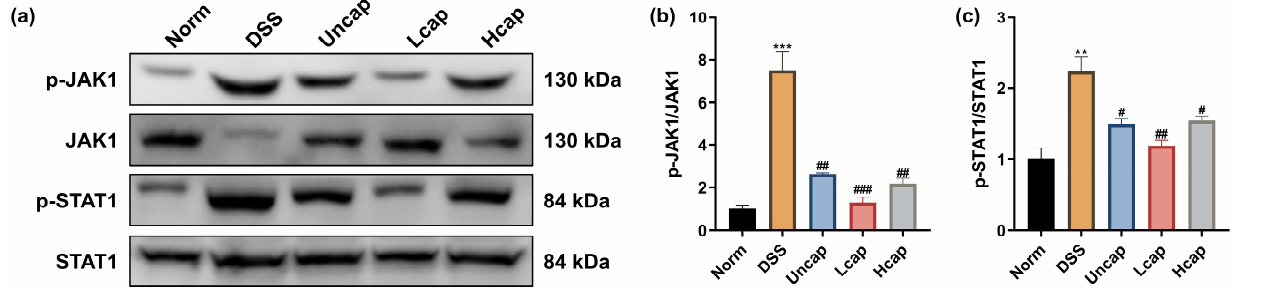
Figure 6. S. spongiosa polysaccharides modulate the JAK/STAT pathway in colitis mice. ( a ) The protein abundances of p-JAK1, JAK1, p-STAT1 and STAT1 were estimated by Western blotting analysis. ( b ) The normalization of p-JAK1 to JAK1. ( c ) The normalization of p-STAT1 to STAT1. The values are reported as means ± SD ( n = 8). ** p < 0.01 and *** p < 0.001 vs. Norm group; # p < 0.05, ## p < 0.01 and ### p < 0.001 vs. DSS